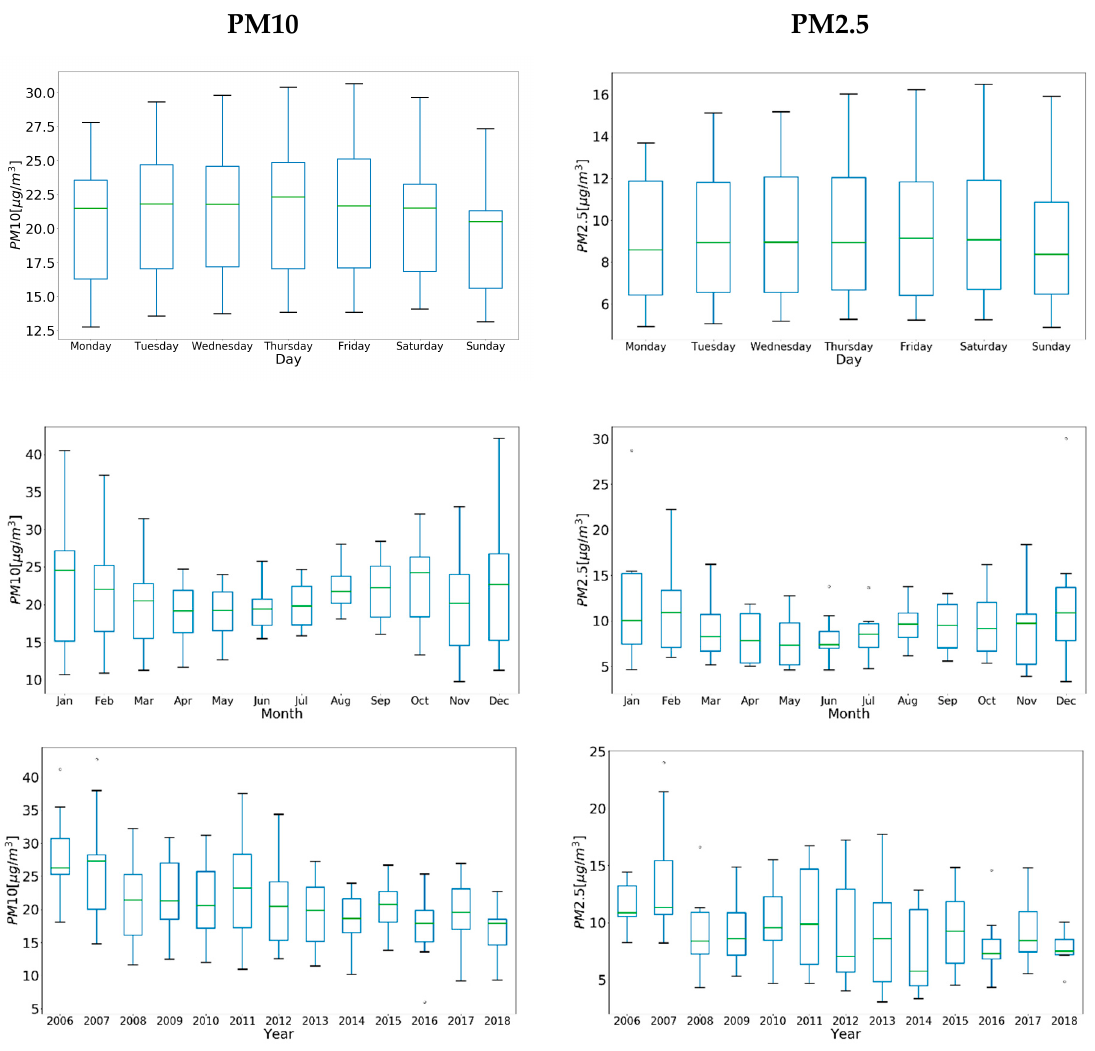
Figure 3. Weekly (upper panel), monthly (middle panel) and annual (lower panel) PM10 and PM2.5 values for mainland Portugal between 2006 and 2018. Small dots represent